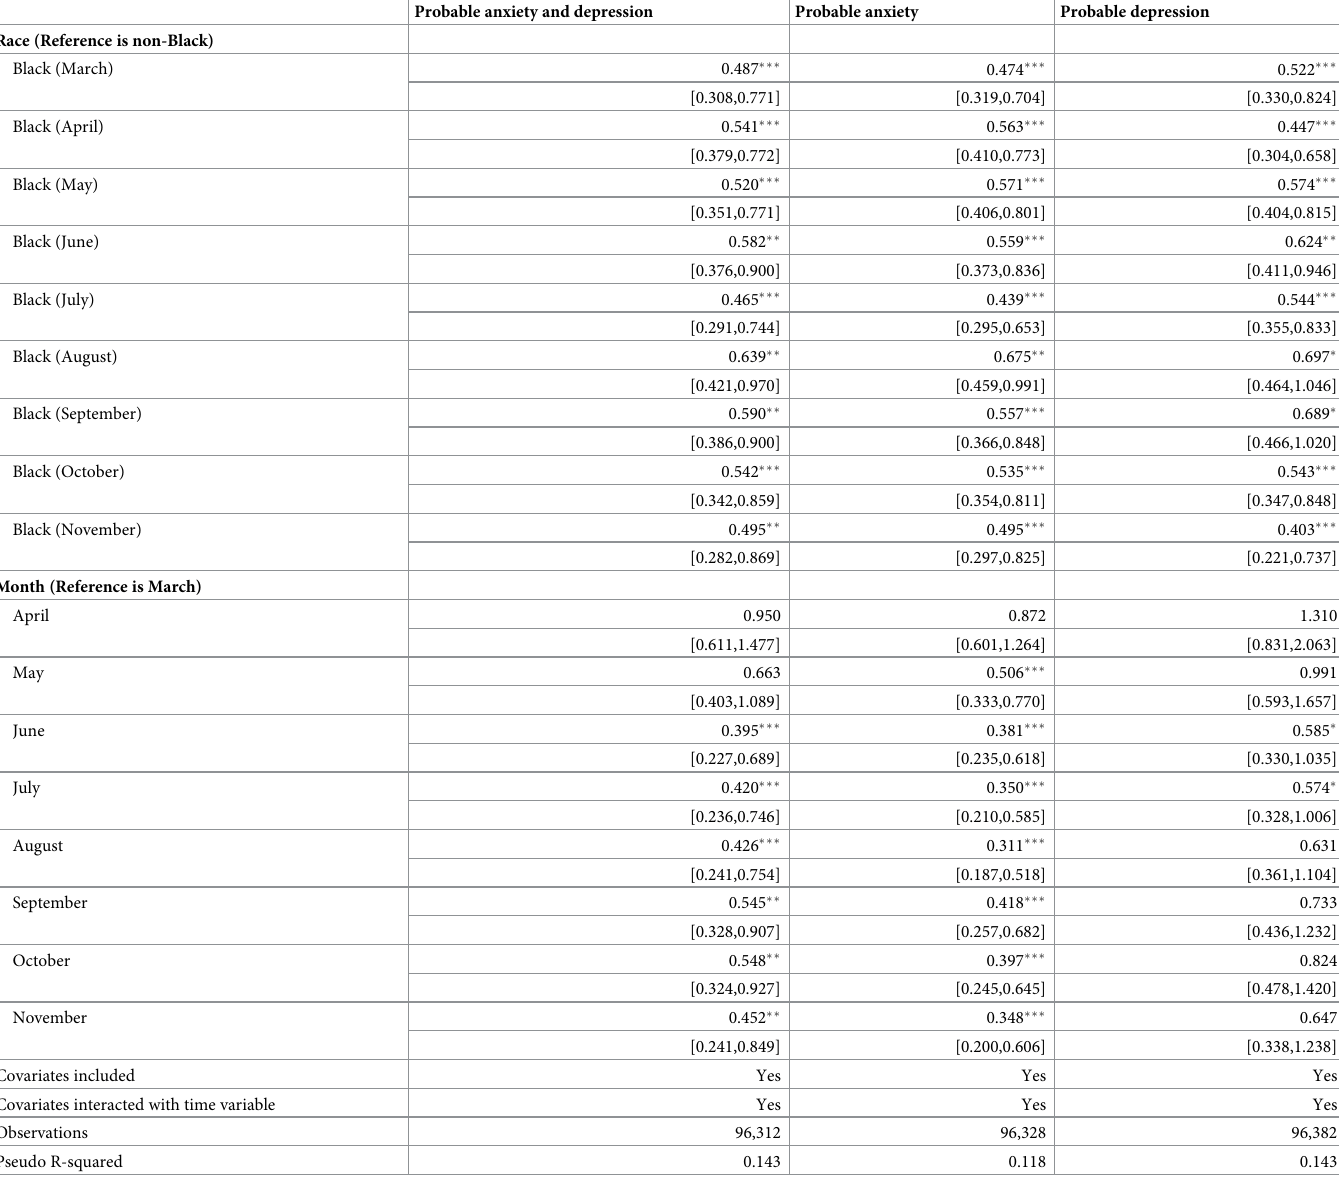
Probable anxiety and depression Probable anxiety Probable